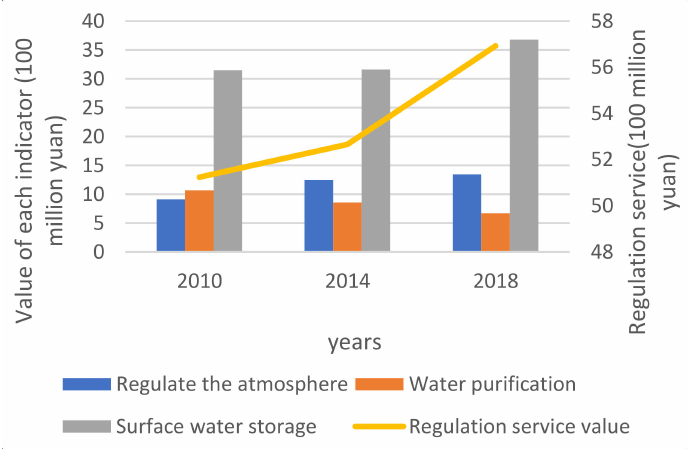
Figure 5. Regulation service value.